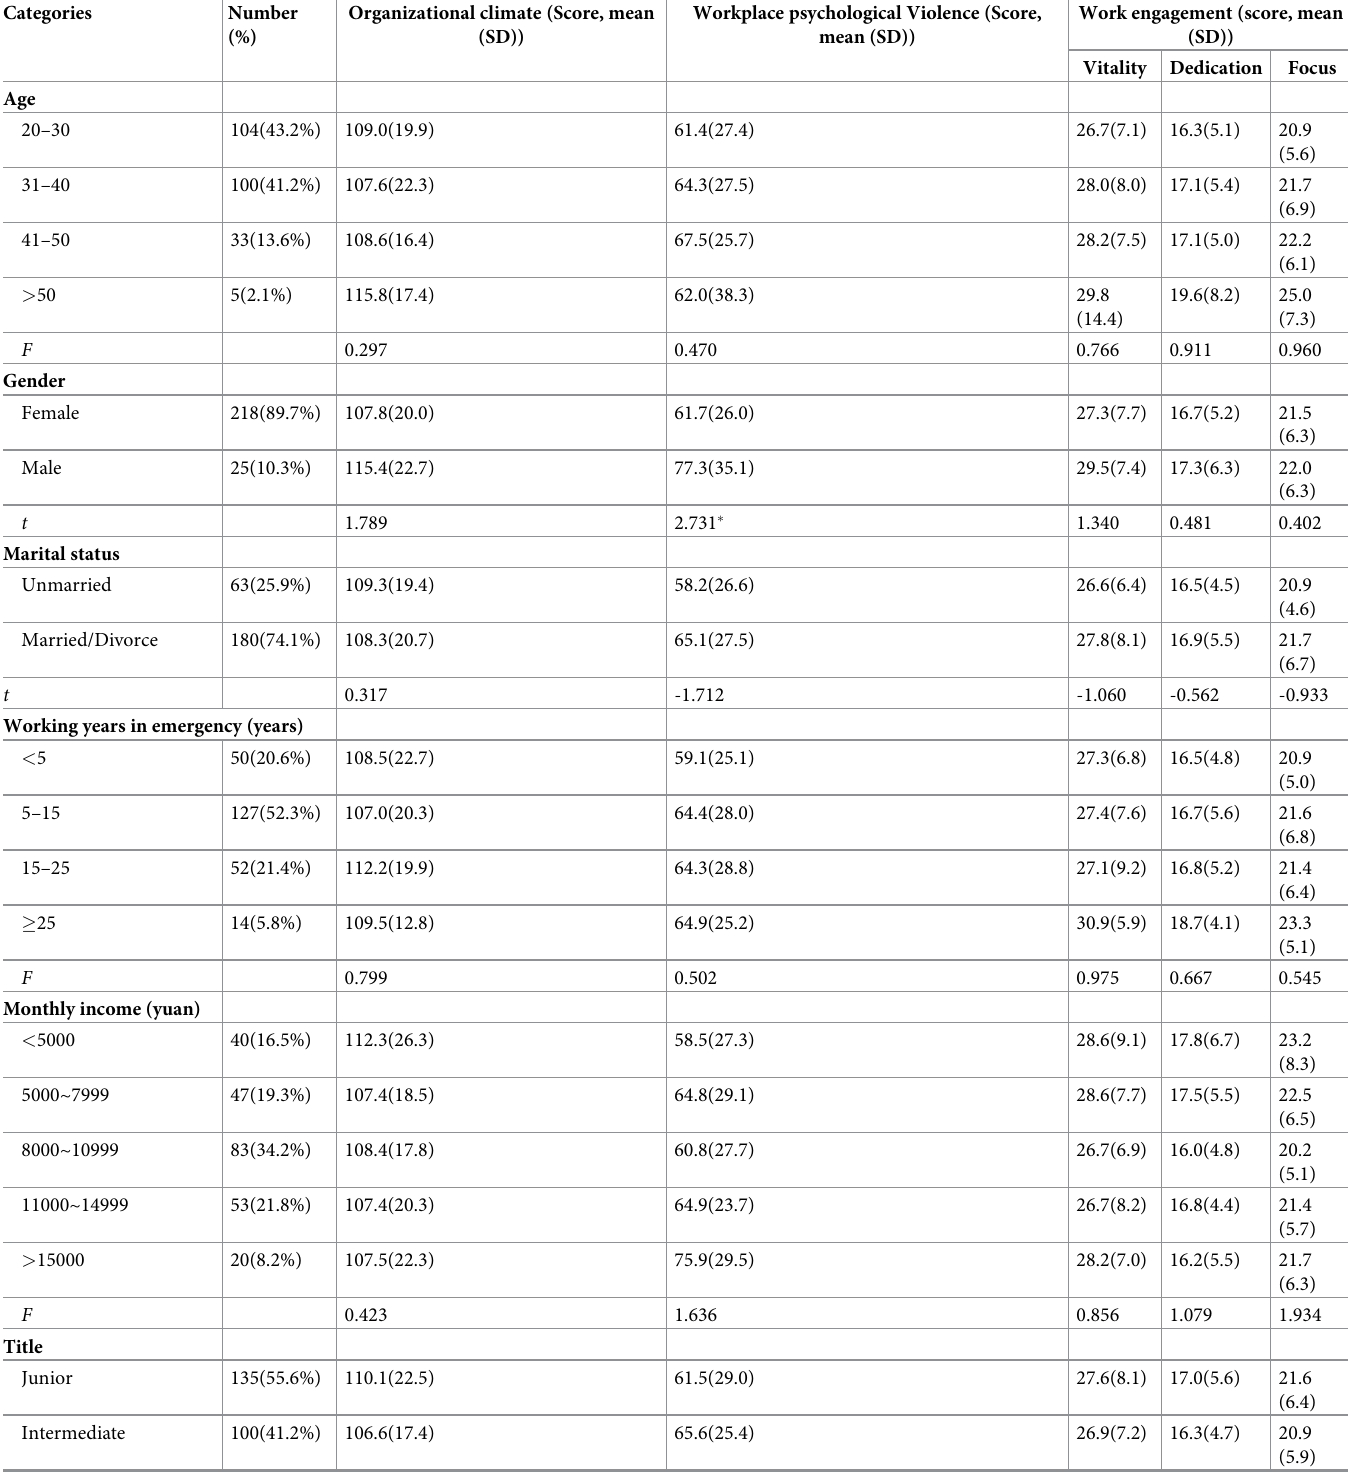
Table 2. The demographic